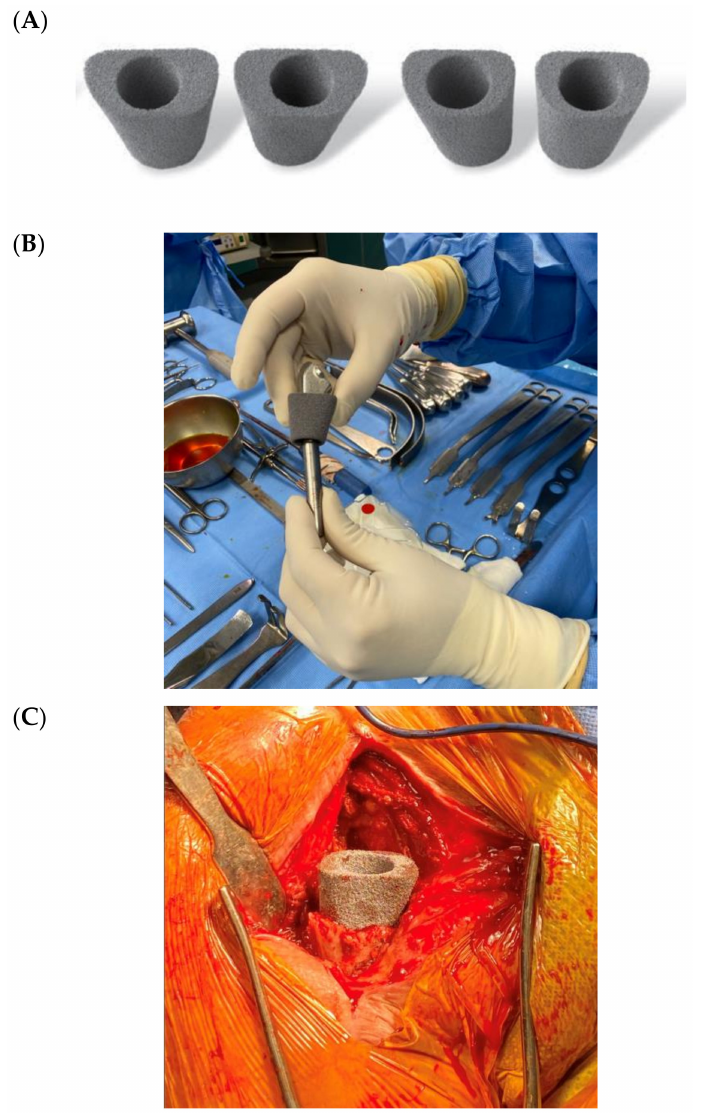
Figure 3. ( A ) Tantalum cones for femoral diaphysis defects in knee arthroplasty revision; ( B ) adaptation for a humeral stem and ( C ) augmentation in the humerus